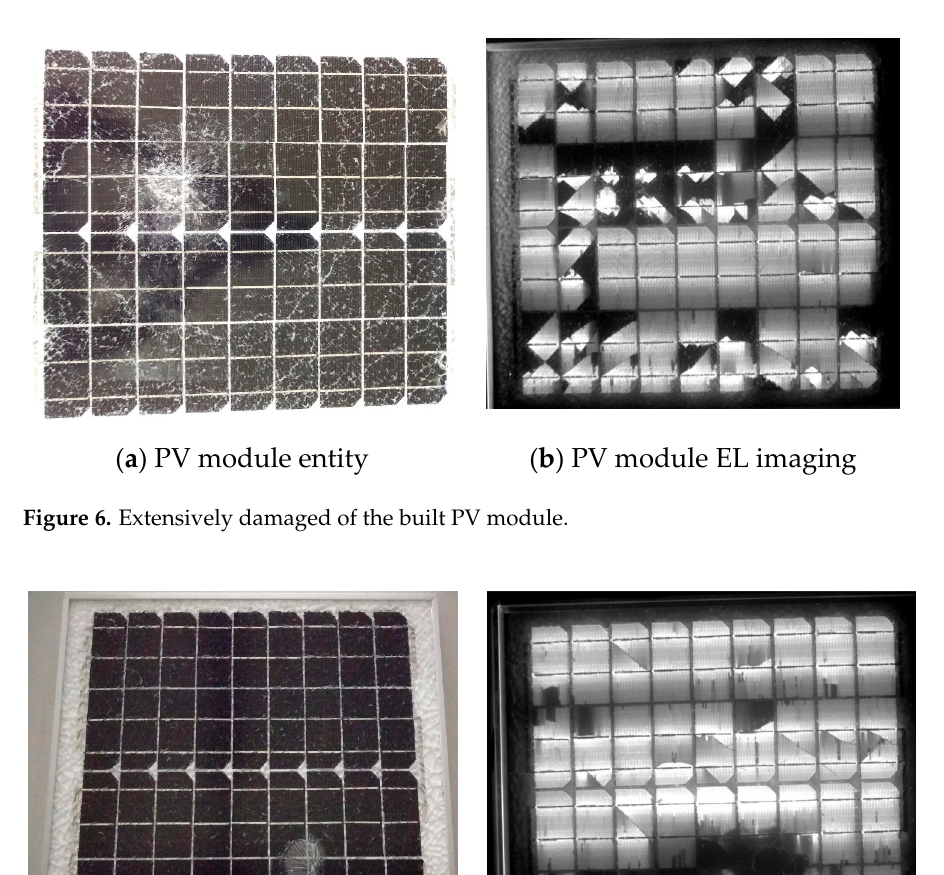
Figure 6. Extensively damaged of the built PV module.